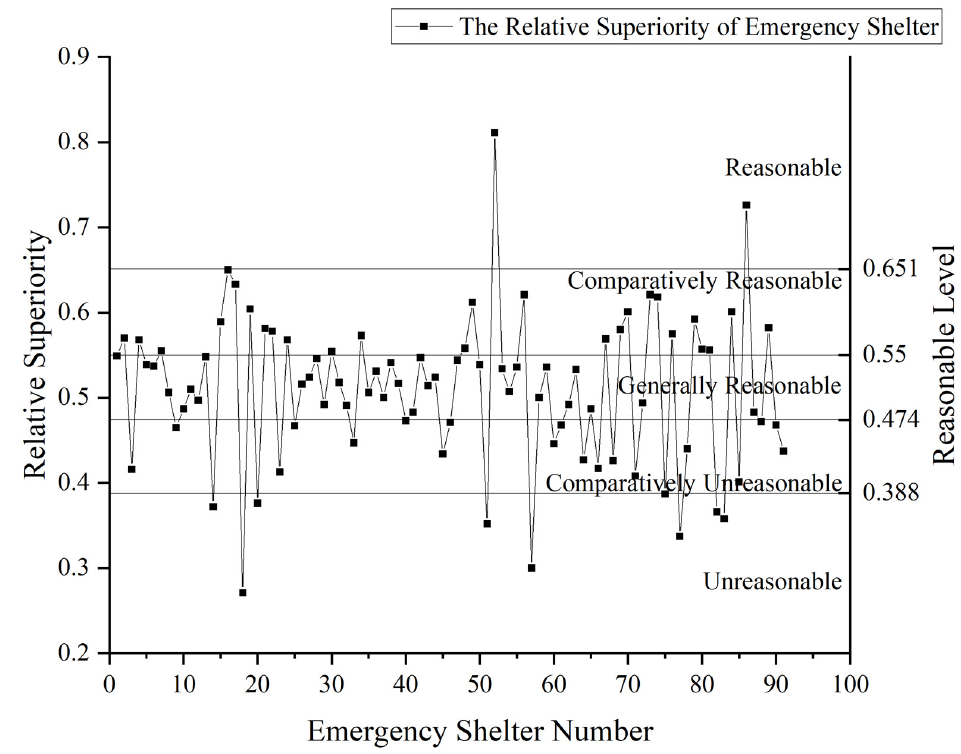
Figure 5. Evaluation results of the spatial distribution of individual emergency shelters.